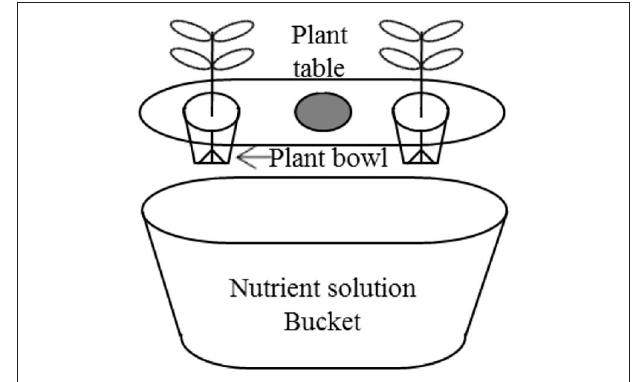
FIGURE 1 | Setup of a hydroponic Power’s